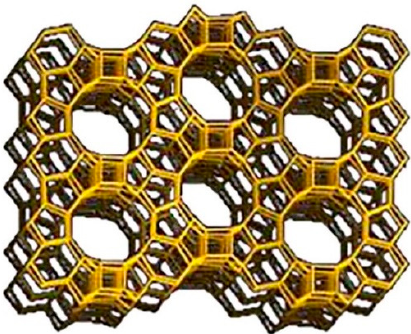
Figure 9. Schematic diagram of beta-zeolite. Reprinted from Reference [78], with permission from Elsevier.